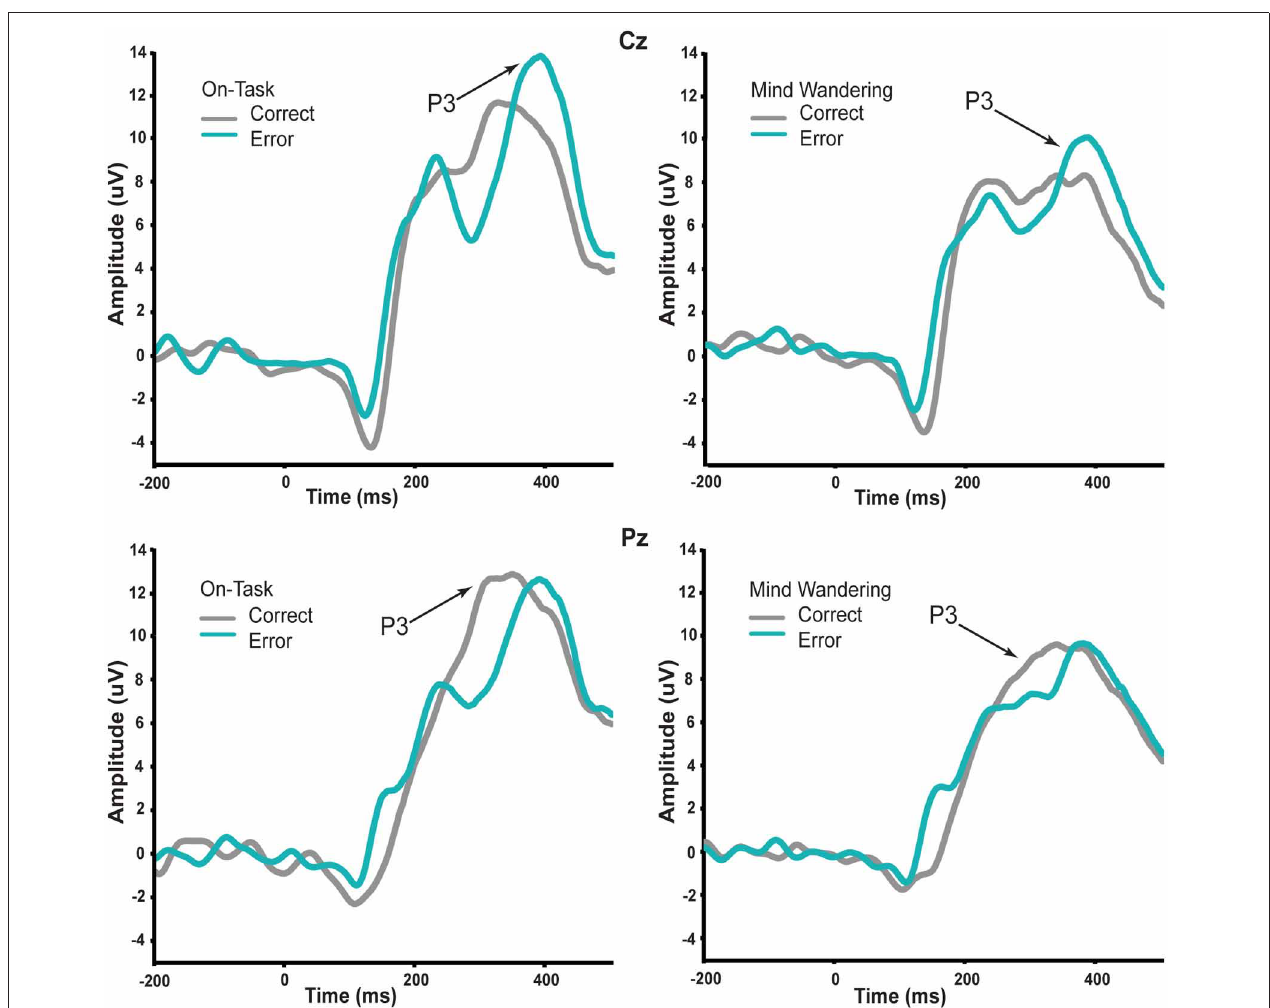
FIGURE 3 | P3 in response to correct and error feedback during on-task and mind wandering attentional states. The amplitude of P3 at both Cz and Pz time-locked to the visual feedback stimulus was significantly reduced regardless of feedback valence during periods of mind wandering relative to periods of